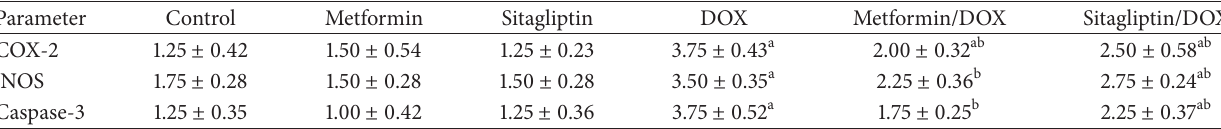
Table 3: Effect of metformin or sitagliptin on the immunohistochemical enzymatic expression of COX-2, iNOS, and caspase-3 in DOX- induced cardiotoxicity in rats.